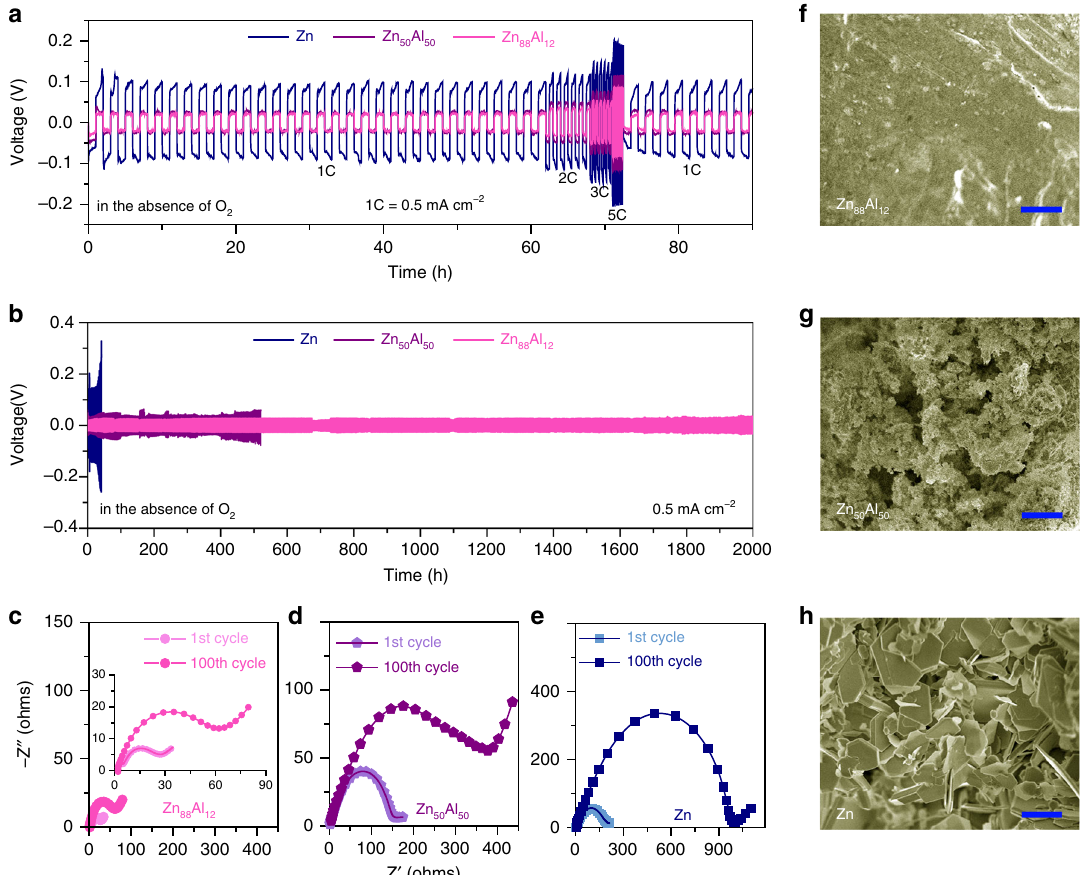
Fig. 4 Electrochemical performance of symmetric batteries of Zn or Zn-Al alloy electrodes. a Comparison of voltage pro fi les for monometallic Zn, hypoeutectic Zn 50 Al 50 and eutectic Zn 88 Al 12 ( λ = ∼ 450 nm) symmetric batteries during Zn stripping/plating at various current densities from 1 to 5 C